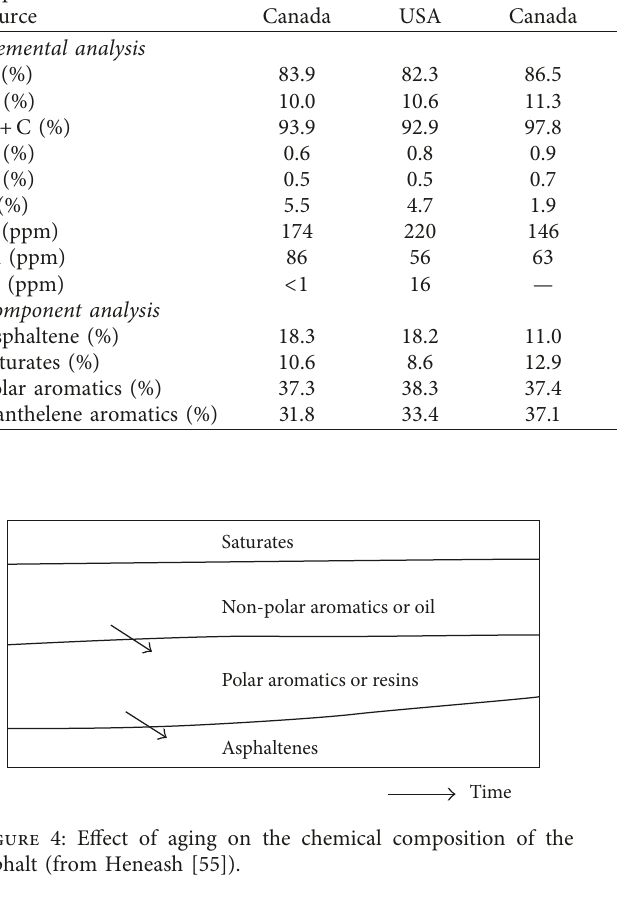
Table 2: Elemental and component analysis of SHRP core asphalts by Asphalt Institute (from Mortazavi and Moulthrop [42]). Asphalt code and crude source Elemental analysis